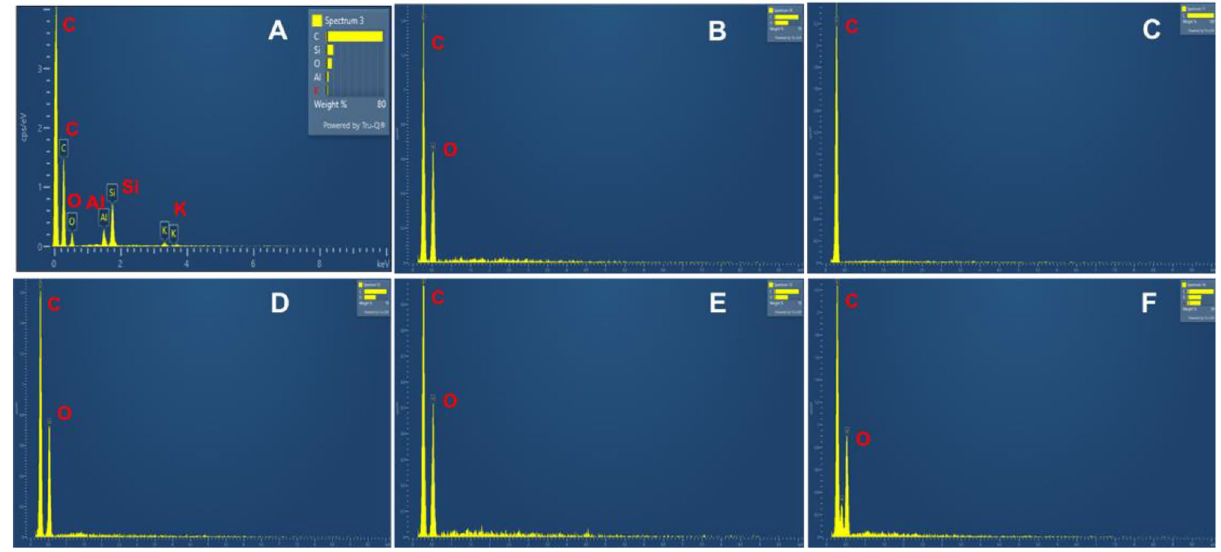
Figure 7. EDX elemental analysis of the six approved face masks. ( A ) surgical. ( B ) reusable cotton. ( C ) FFP2. ( D ) FFP3. ( E ) antiviral. ( F )